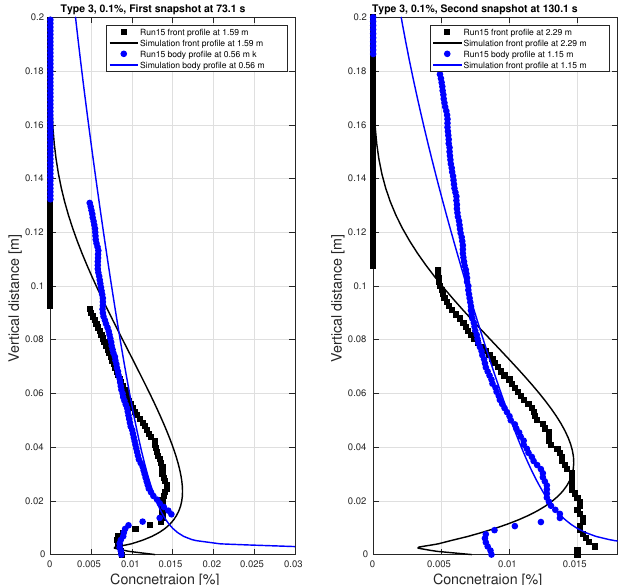
Figure 16. Validation case for run15. Vertical concentration profiles are shown for the front and the body of the current. The first snapshot is taken when the front of the current has almost reached the middle of the